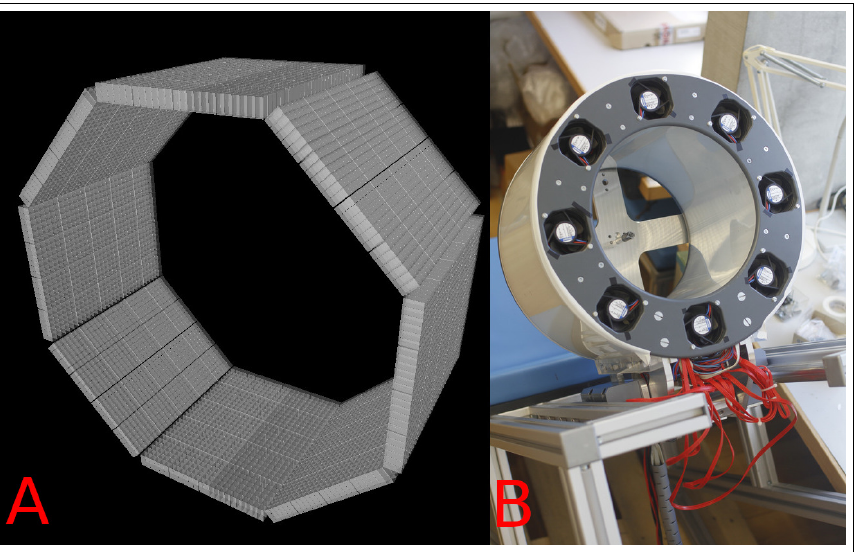
Figure 2. Left ( A ): computer render of the crystal layout. Right ( B ): physical BPET scanner attached to a